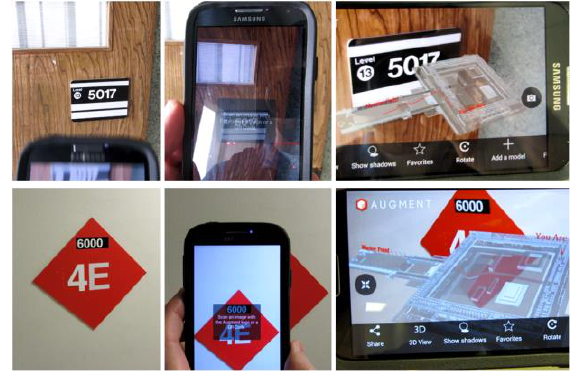
Figure 3. Augmenting the existing building signage